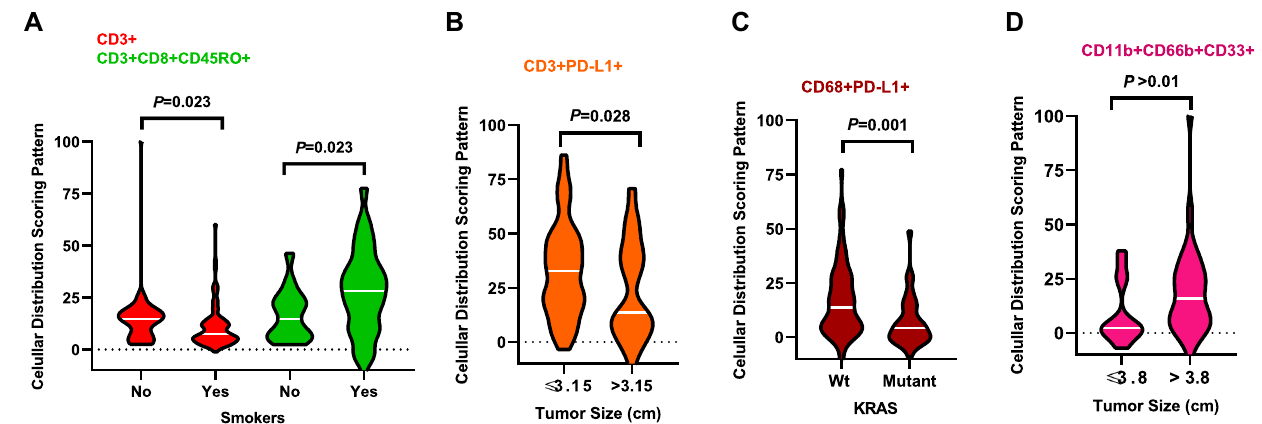
Fig. 4 | Violin plots showing associations between patterns of immune cell distribution and clinicopathologic features. Signi fi cant cellular distribution scoring patterns between immune cells and malignant cells are shown by ( A ) smoker status, ( B ) tumor size, and ( C ) KRAS mutation status for lung adenocarci- noma ( n =142) specimens. D Signi fi cant cellular distribution scoring patterns between malignant cells and immune cells are shown by tumor size for lung